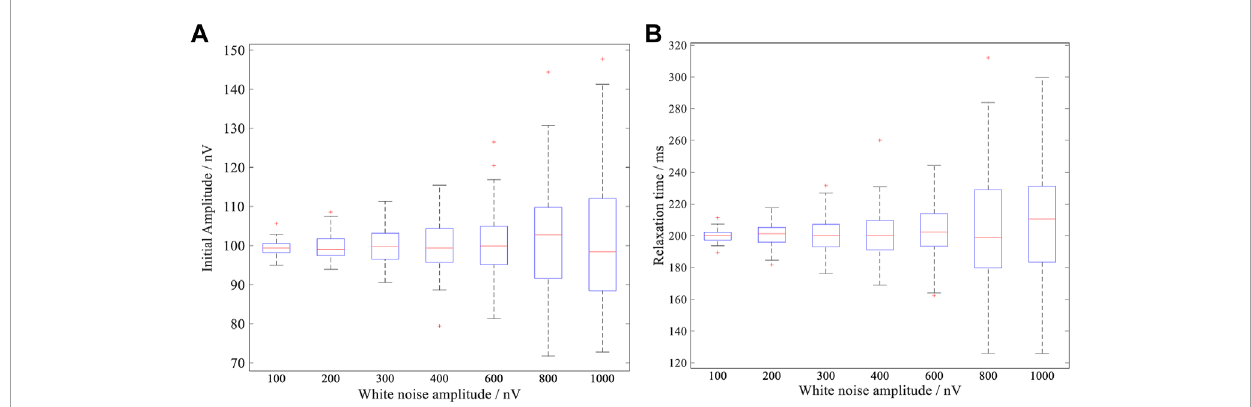
FIGURE 3 The fitting errors of related parameters under different power frequency harmonic amplitudes; (A) Boxplot of initial amplitude fitting values at different power frequency harmonic amplitudes; (B) Boxplot of relaxation time fitting values at different power frequency harmonic amplitude.